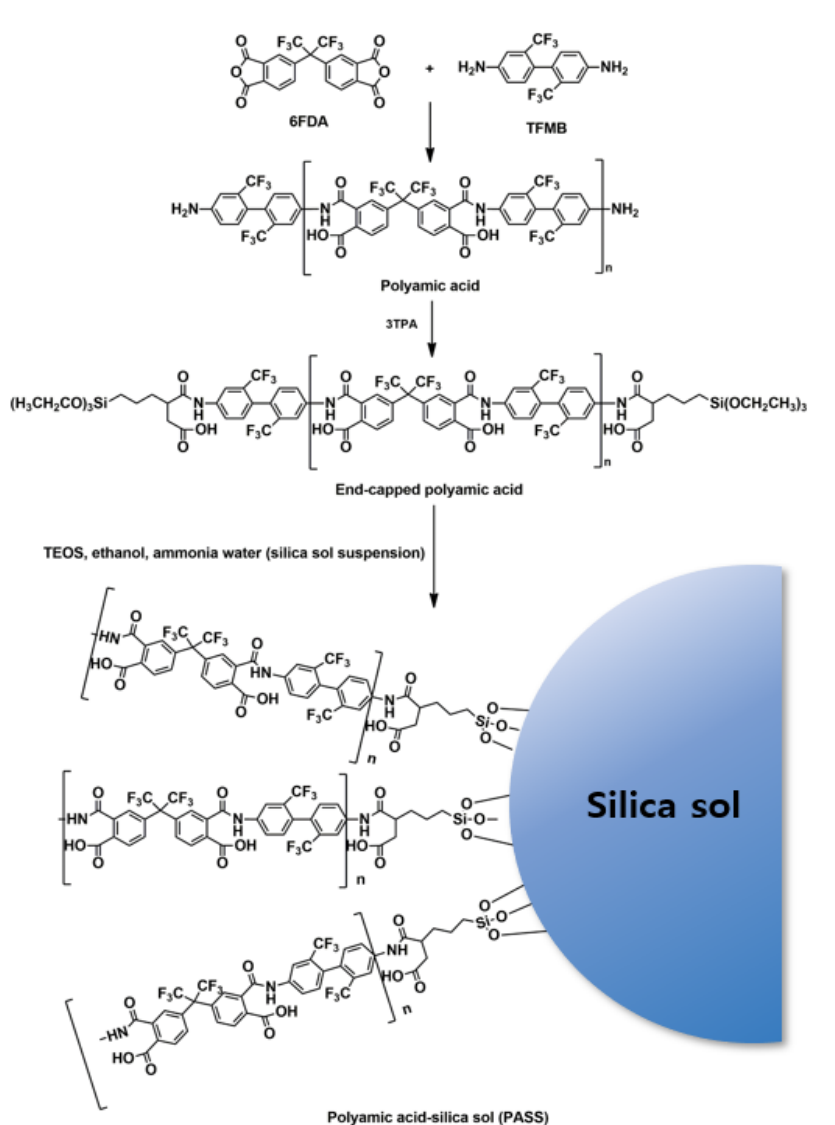
Figure 1. Synthesis of PASS suspensions. Table 1. Polyimide-fluorinated silica sol (PIFSS) coatings and their